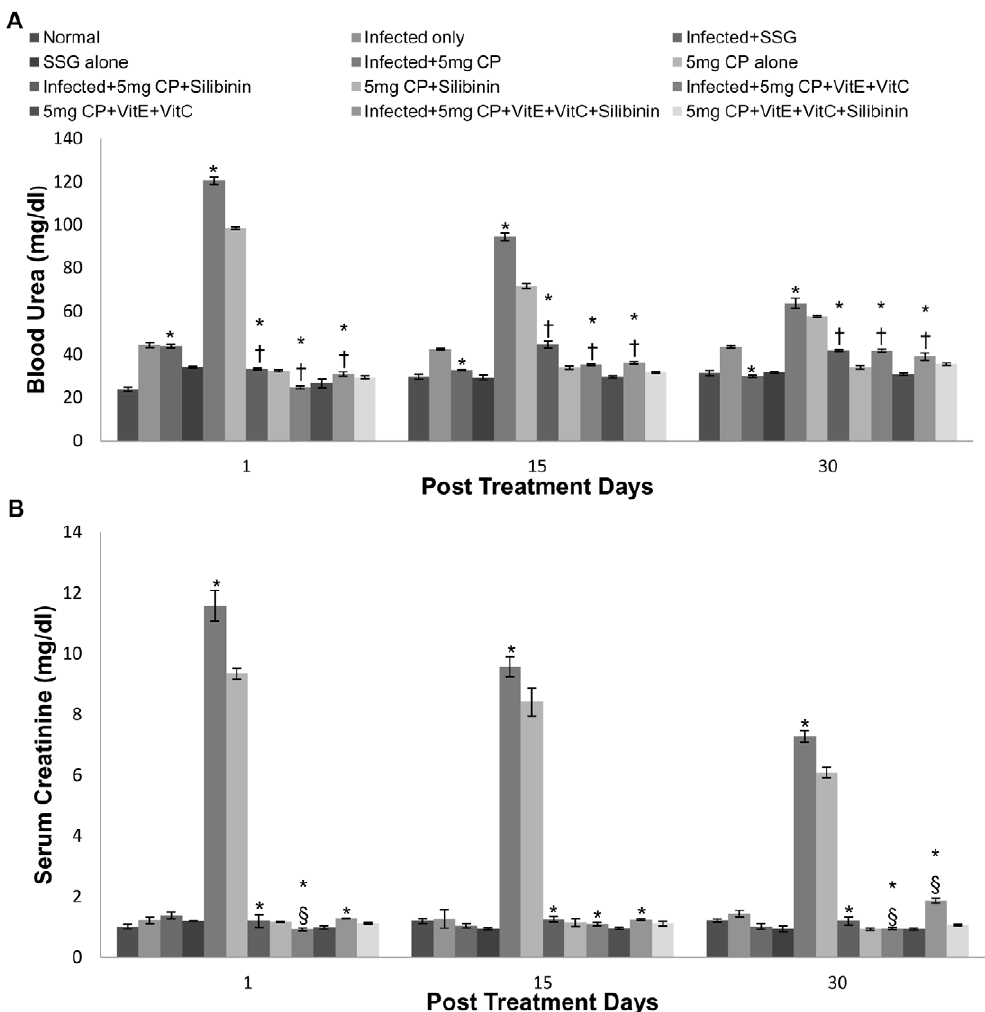
Figure 8. Blood urea and creatinine levels in serum samples of different groups of animals. A- Blood Urea, B- Creatinine. The data are presented as mean 6 S.D. of six mice per group. * -p value: Infected only vs Infected + SSG/Infected + 5 mg CP/Infected + 5 mg CP + Silibinin/ Infected + 5 mg CP + VitE + VitC/Infected + 5 mg CP + VitE + VitC + Silibinin. { , 1 -p value: Infected + 5 mg CP vs. Infected + 5 mg CP + Silibinin/Infected + 5 mg CP + VitE + VitC/Infected + 5 mg CP + VitE + VitC + Silibinin. *, { -p , 0.001; 1 -p ,